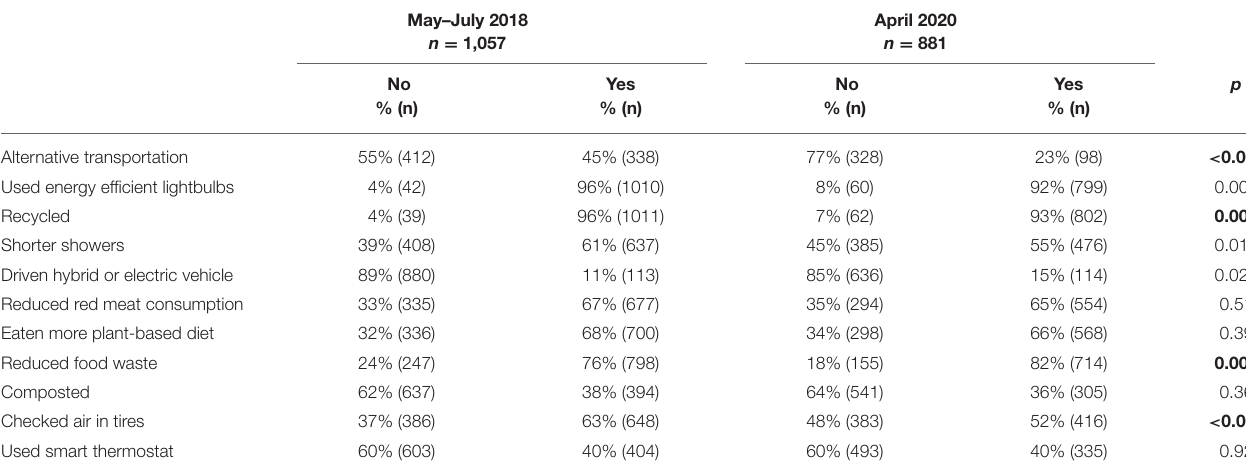
TABLE 3 | Proportions and counts of responses and chi-squared results in unmatched